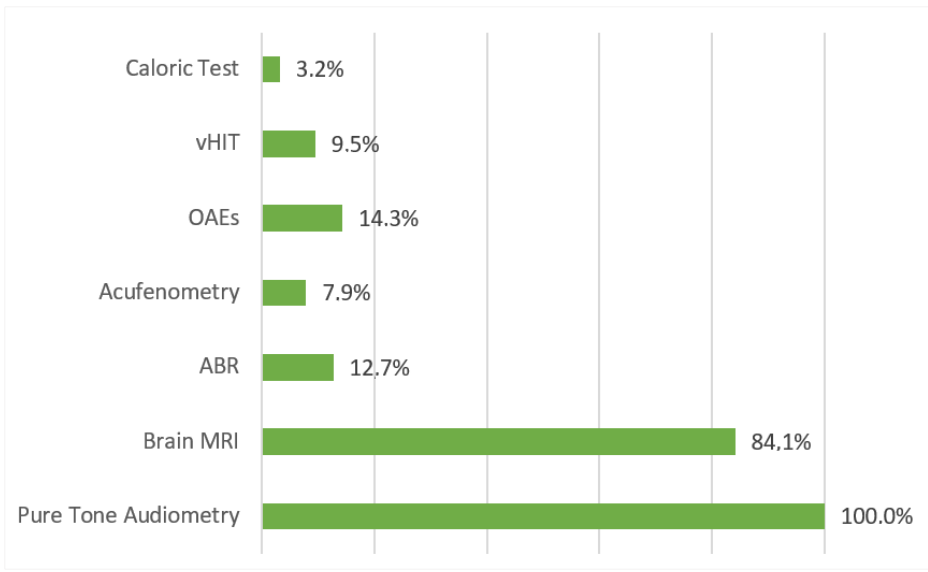
Figure 4. The frequency of audiological diagnostic tests that were used to assess the hearing status of the COVID-19 patients. the COVID-19